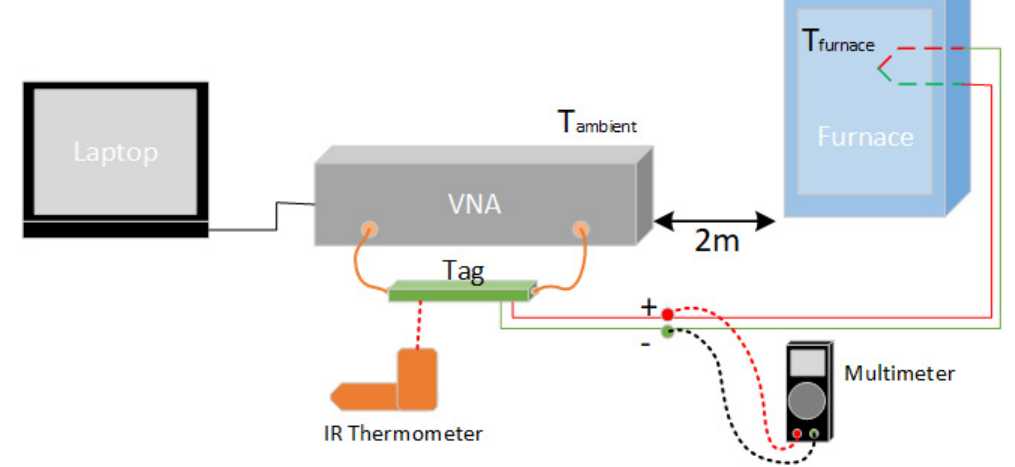
Figure 4. Thermocouple interfaced circuit test setup.